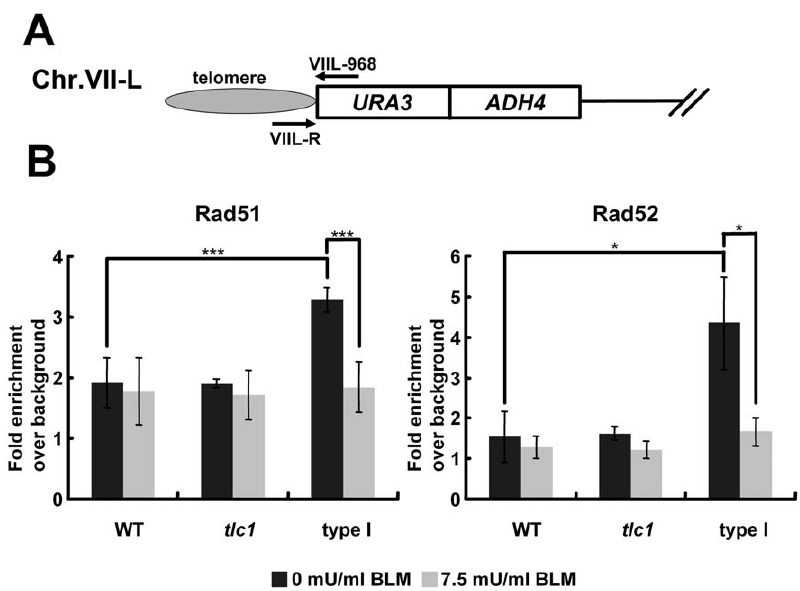
Figure 5. Sequestration of repair proteins at telomeres in type I survivors. ( A ) The left arm of chromosome VII-L in YPH499 UT strain was modified by integration of fragments containing the URA3 and telomeric sequence at the ADH4 locus. Telomeres are represented by hatched ovals; arrows indicate primers used for real-time PCR. ( B ) ChIPs were performed and quantitated by real-time PCR as described in Materials and Methods. Error bars represent standard deviations for at least three independent experiments. Before the addition of bleomycin (black bars), bindings of Rad51 and Rad52 to the VII-L telomere in type I cells differed from those in wild-type in a statistically significant manner ( P values =5.36 6 10 2 8 and 0.010, respectively), and their bindings to the VII-L telomere was statistically indistinguishable in pre-senescent tlc1 mutant and wild-type strains. In type I cells, bindings of Rad51 and Rad52 to the VII-L telomere before bleomycin treatment (black bars) differed from those after treatment (gray bars) in a statistically significant manner ( P values =0.0004 and 0.014, respectively). This discrepancy was not observed in both pre-senescent tlc1 mutant and wild-type strains.